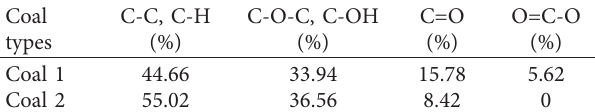
Table 2: Fraction of C on two coal samples (relative % of C1